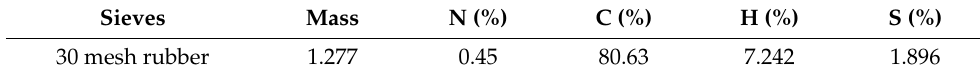
Table 3. The element content results of the crumb rubber sample with 30 mesh.